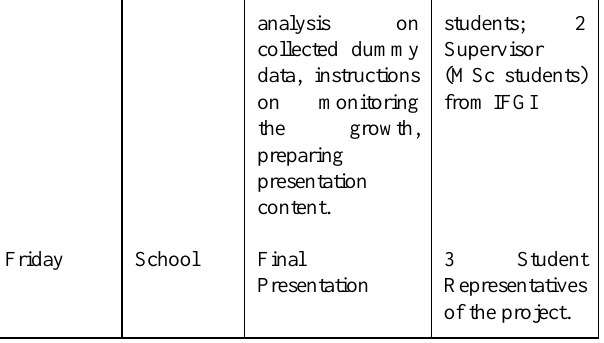
Table 2: Daily Activity schedule during project week